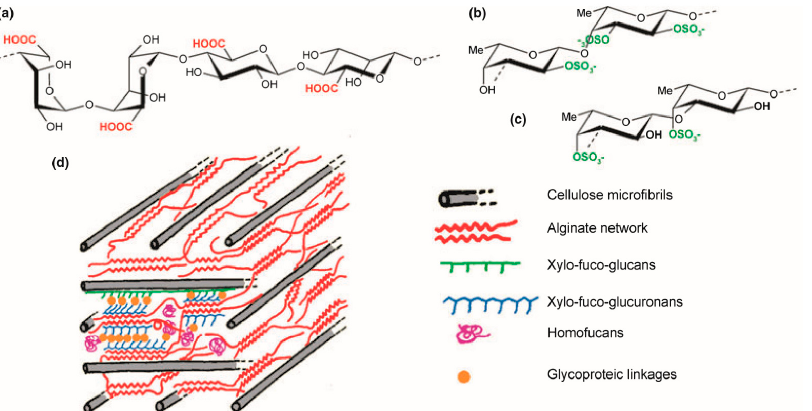
Figure 1. The main polysaccharide structures of brown alga: ( a ) alginate; ( b ) sulphated fucan from Fucales; ( c ) sulphated fucan from Ectocarpales; ( d ) proposed model of the biochemical organisation of brown alga cell wall structure. Reproduced with permission from [166] .